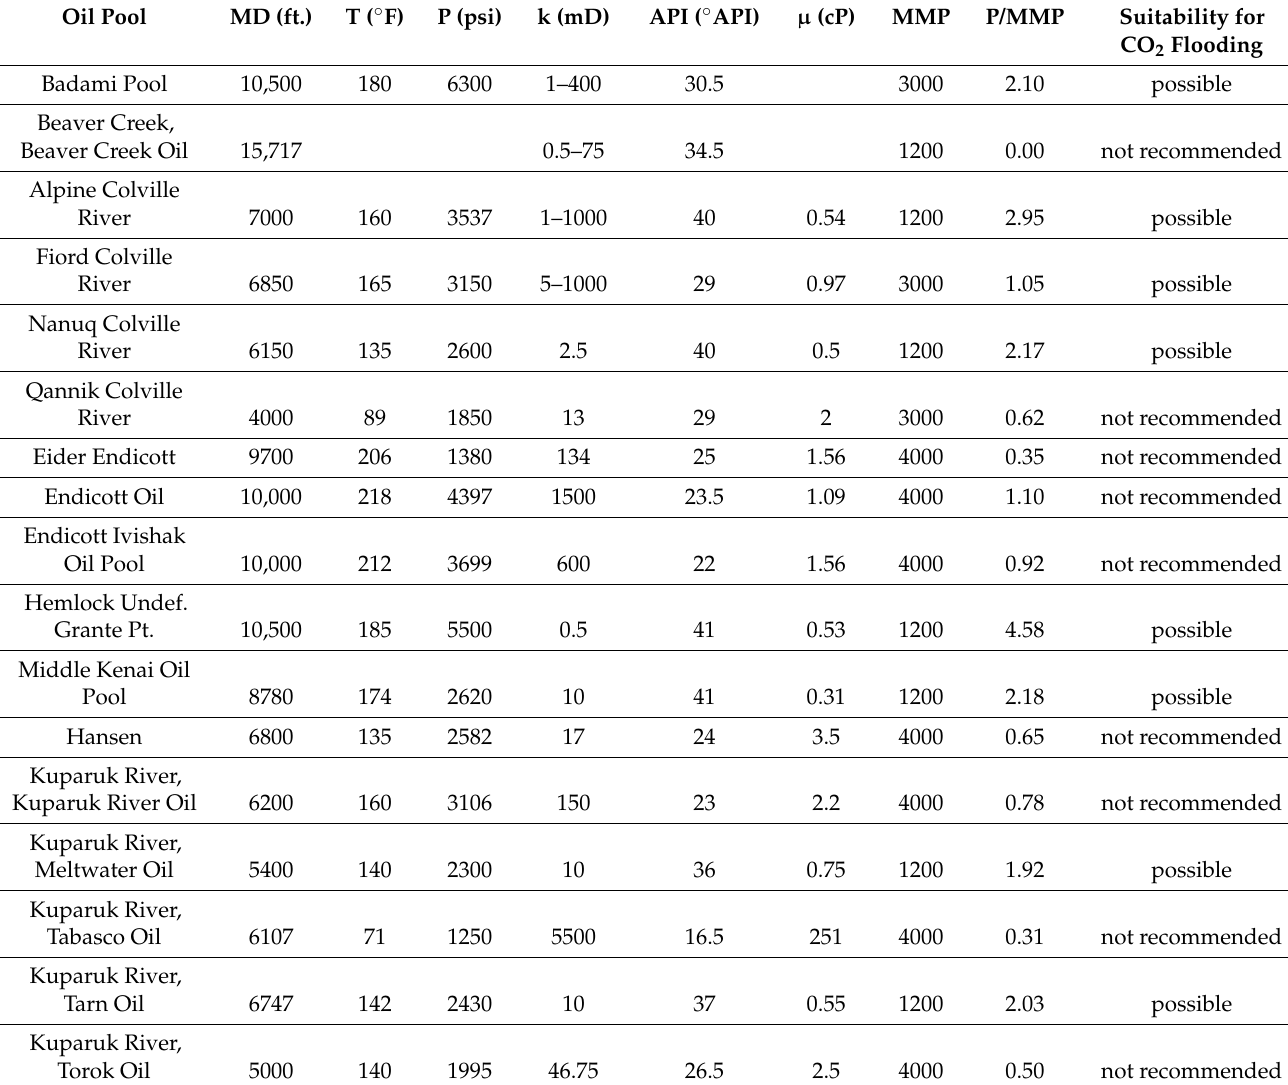
Table 7. CO 2 flooding Screening for Alaskan Oil Pools, Data Gathered from Alaska Oil and Gas Conservation Commission (AOGCC)